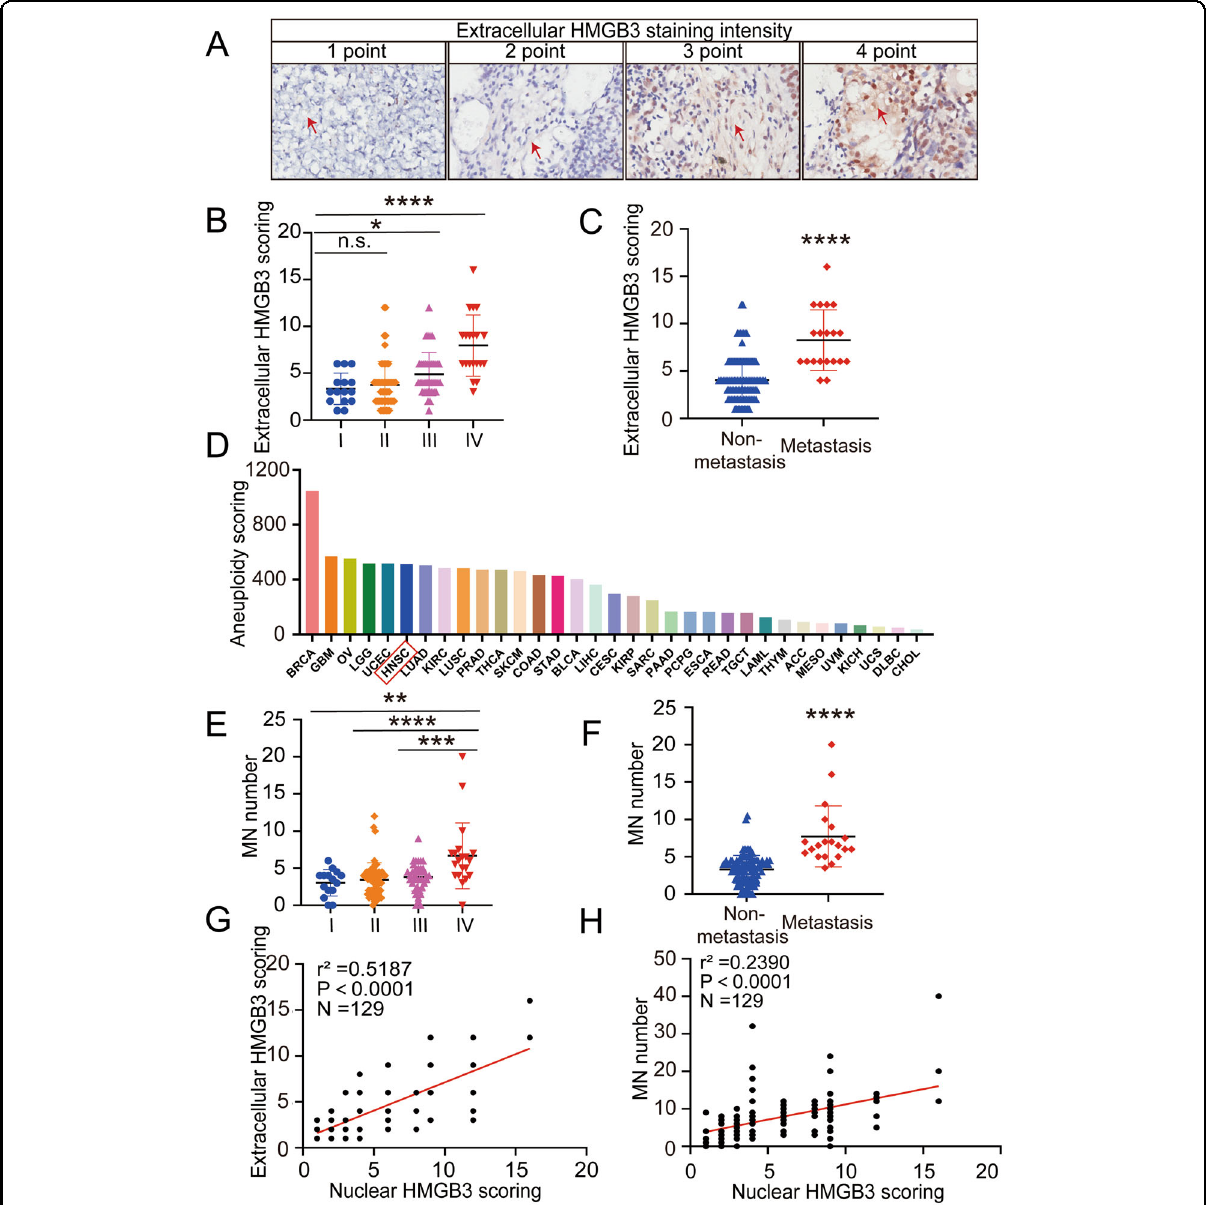
Fig. 2 The relationship of nuclear HMGB3, extracellular HMGB3 and MN numbers. A Representative IHC images of extracellular HMGB3 staining and the red arrow points to part of the extracellular staining area. B Statistical comparison of extracellular HMGB3 score in TNM stages. C Statistical comparison of extracellular HMGB3 score in the two groups with or without metastasis. D The pan-cancer analysis of the chromosome aneuploidy. E Statistical comparison of the MN numbers in TNM stages. F Statistical comparison of the MN numbers in the two groups with or without metastasis. G Spearman correlation between nuclear HMGB3 score and extracellular HMGB3 score. H Spearman correlation between nuclear HMGB3 score and the MN numbers. Pearson correlation coef fi cient ( r 2 ) and P value are shown. Mean ± SD, * P < 0.05, ** P < 0.01, *** P < 0.001, **** P < 0.0001, student ’ s